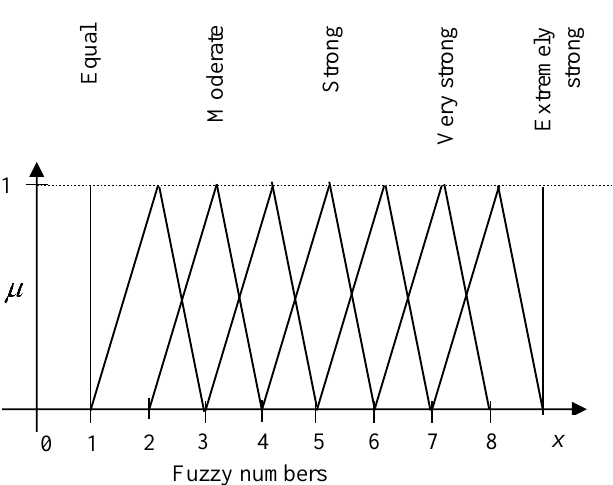
Fig. 3. Membership function of parameters for the cocoa pod husk composite for water absorption process (fuzzy